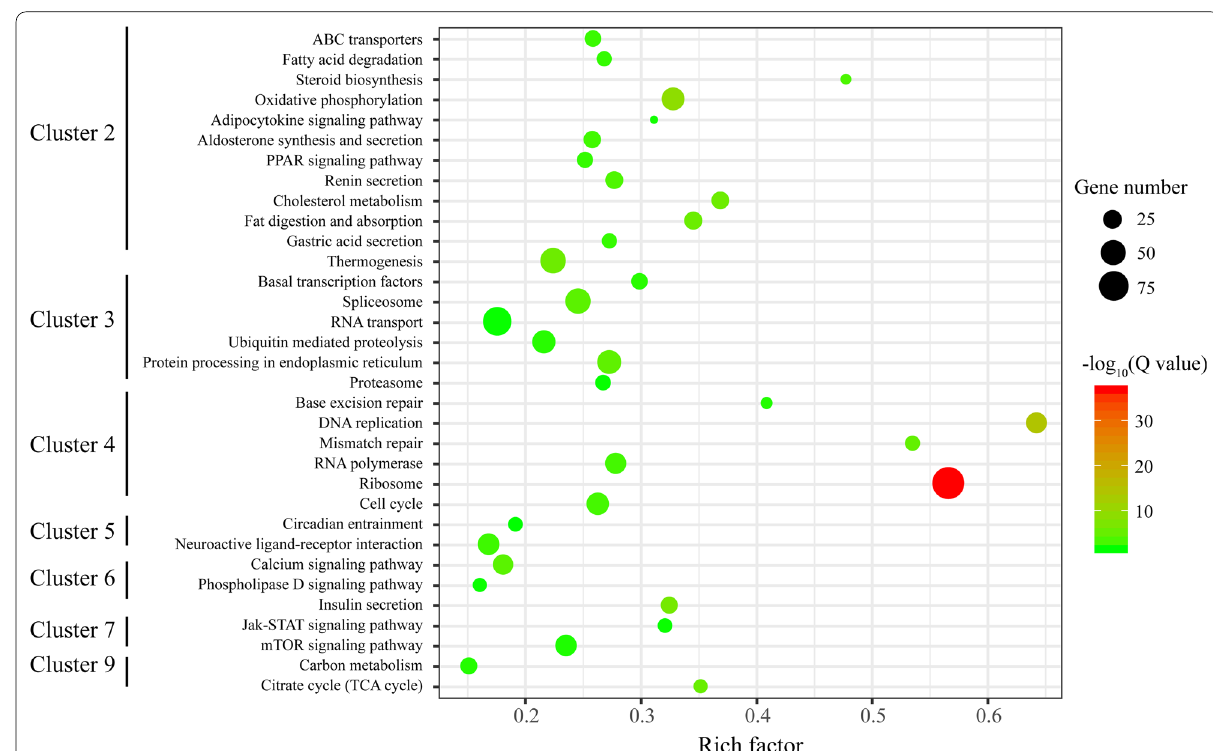
Fig. 6 Significantly enriched KEGG signaling pathways corresponding to 9 distinct gene expression clusters. Significantly enriched pathways were determined at adjusted P < 0.05 through the hypergeometric test. Rich factor is the proportion of genes enriched into the target